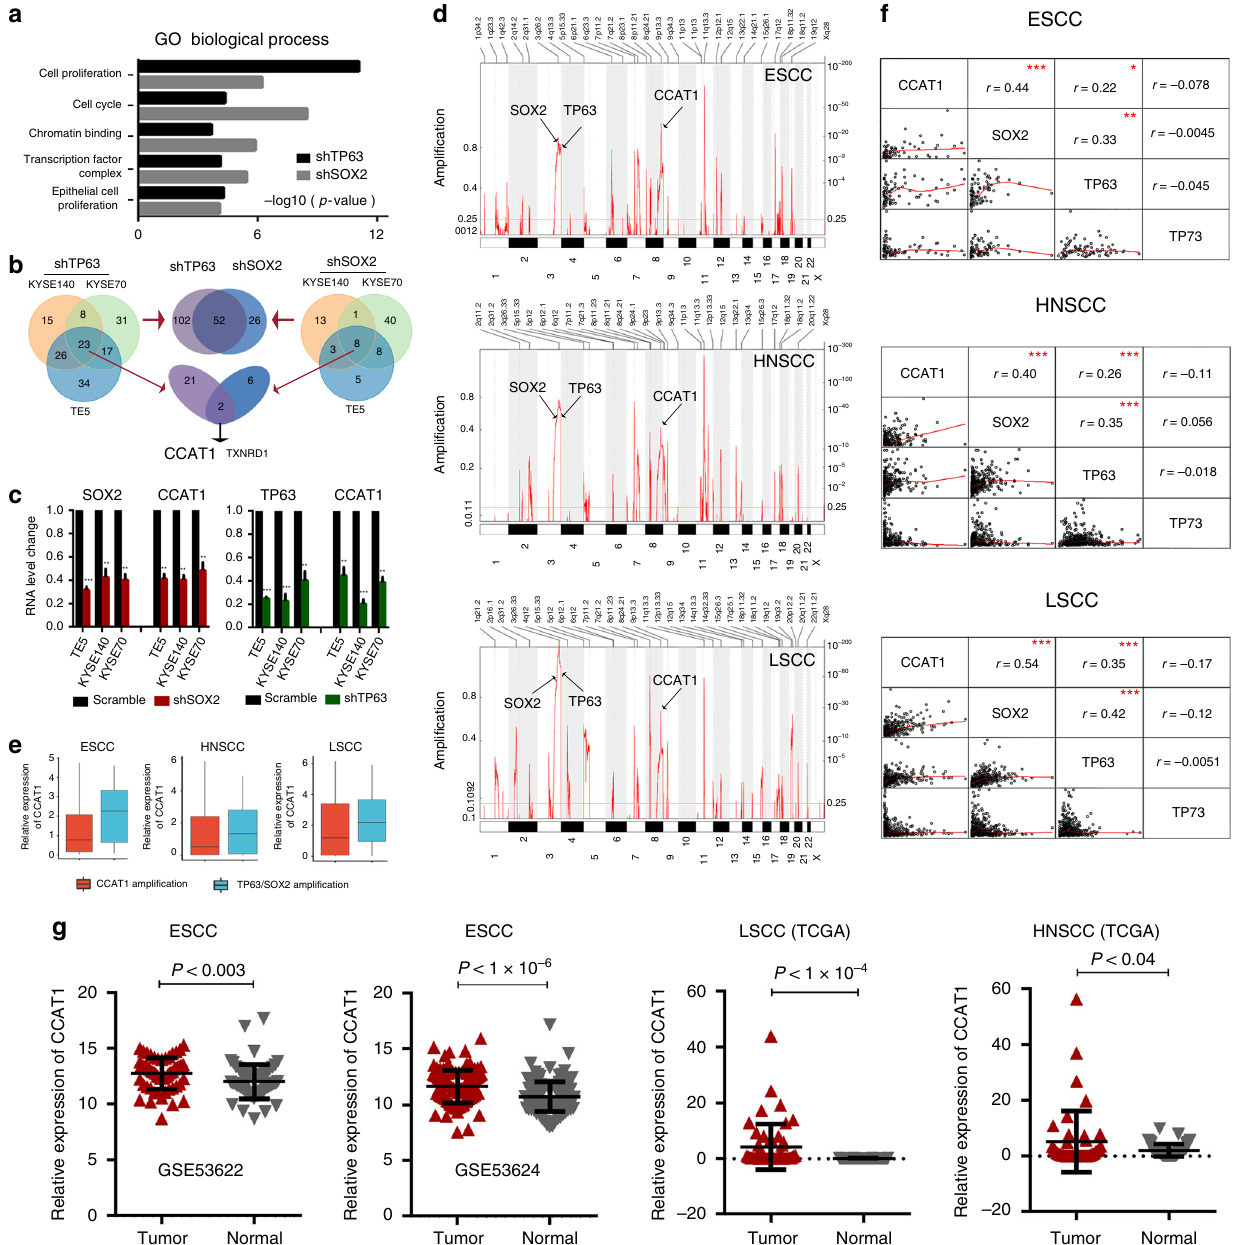
Fig. 2 CCAT1 is overexpressed and regulated by TP63 and SOX2 in SCCs. a GO functional categories of downregulated genes upon TP63 or SOX2 silencing. b Integrative analysis of TP63 and SOX2 co-regulated downstream super-enhancer targets, which are co-occupied by TP63 and SOX2 in three SCC cell lines. c CCAT1 mRNA expression upon silencing of either TP63 or SOX2. Data are presented as mean ± SD of three replicates. ** P < 0.01, *** P < 0.001. P values were determined using t -test. d Plots showing high-level ampli fi cations of TP63 , SOX2 , and CCAT1 loci in esophageal squamous cell carcinomas (ESCC), head and neck squamous cell carcinomas (HNSCC) and lung squamous cell carcinomas (LSCC). X axis shows chromosomal regions, Y axis shows the G score (left) and false discovery rate q -values (right). e Relative expression of CCAT1 in CCAT1 independently ampli fi ed and TP63 / SOX2 co-ampli fi ed tissues. Red or blue box plot represent CCAT1 or TP63/SOX2 co-ampli fi cation samples, respectively. f Correlation plots comparing CCAT1, SOX2, and TP63 expression in ESCC, HNSCC, and LSCC. TP73 was included as a negative control. r represents correlation value; *represents P values. * P < 0.05, ** P < 0.01, *** P < 0.001. P values were determined using t -test. Data of d – f from the Cancer Genome Atlas Network (TCGA). g CCAT1 expression in tumor and nonmalignant samples across three types of SCCs. Data from GSE53622, GSE53624, and TCGA. Signi fi cance was marked with P